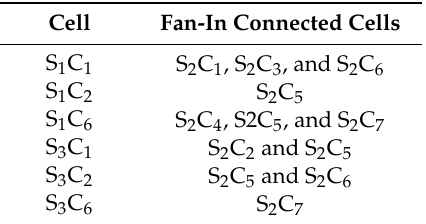
Figure 6. Example of fan-in filter. Table 1. Fan-in connected cells of example in Figure 6.